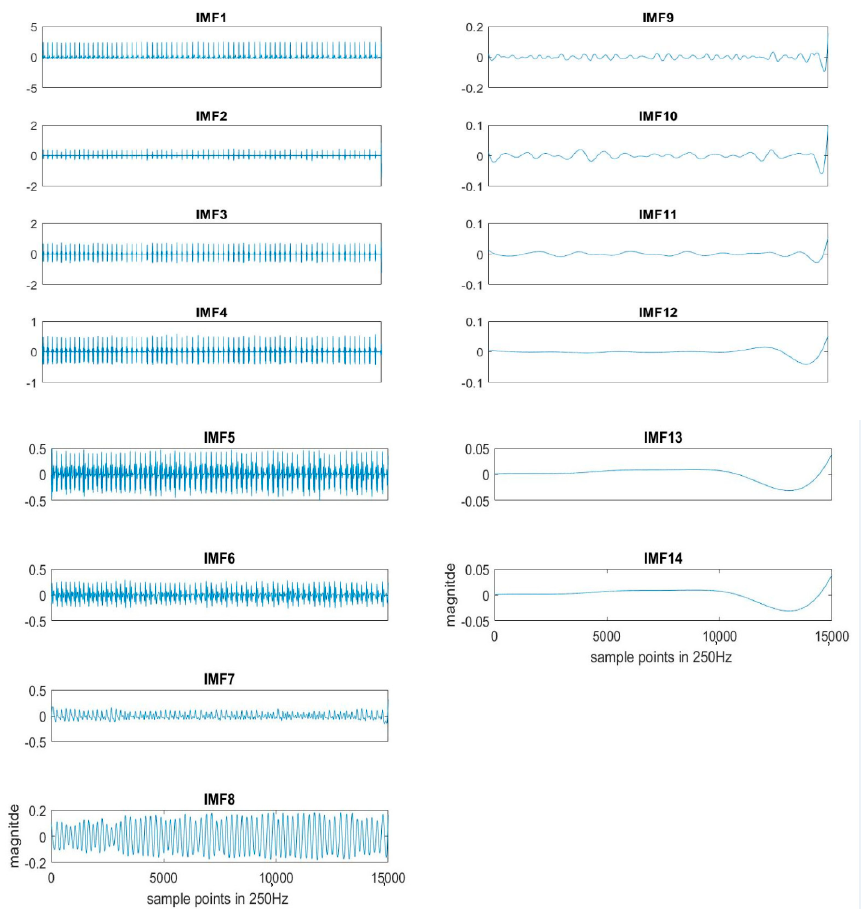
Figure 2. An example of IMFs decomposed by EEMD sifting process from the ECG